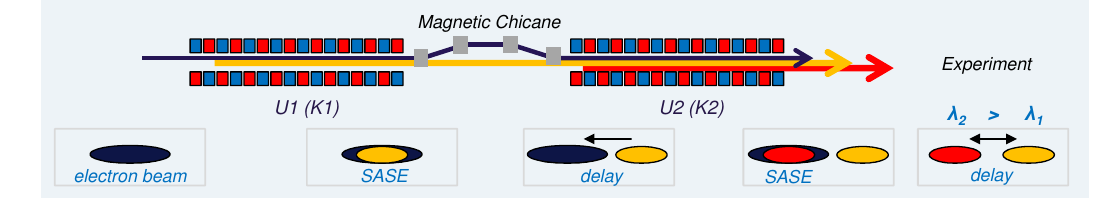
Figure 1. Simplest two-color scheme relying on a single magnetic